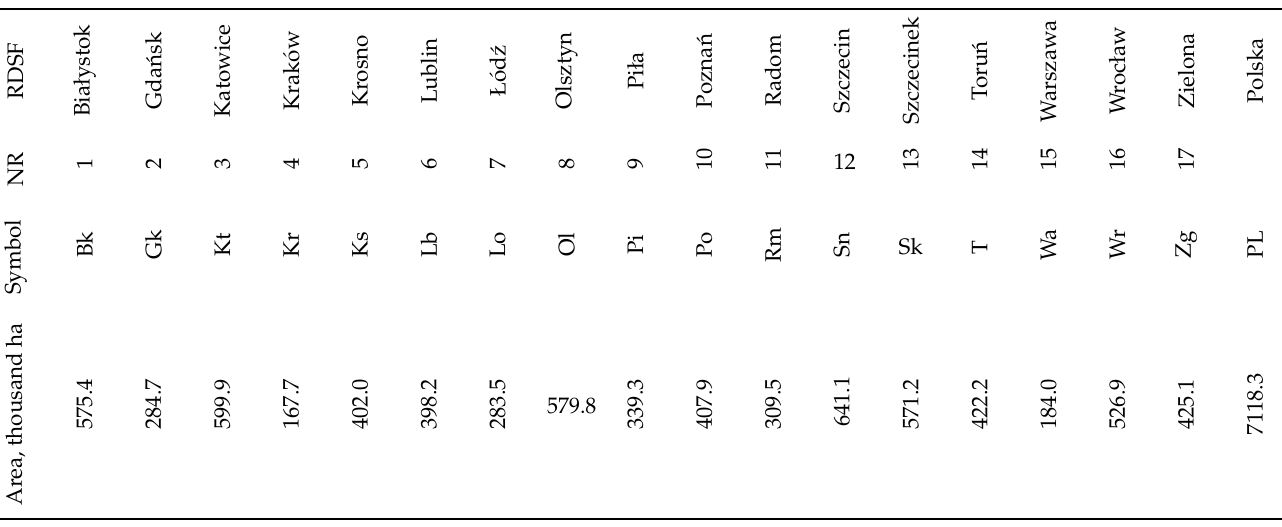
Table 1. Adopted structure of the designation of forest managers (RDSF) in the territory of Poland [88–90].